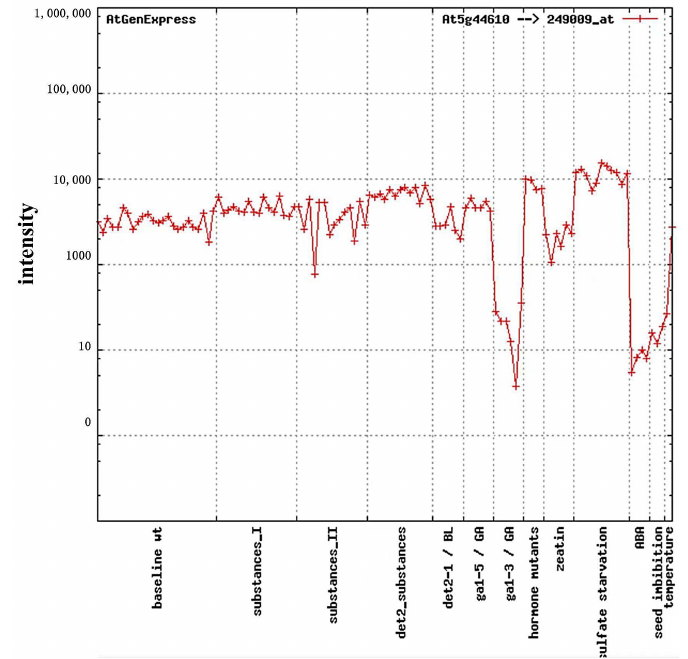
Figure A2. The AtGenExpress Visualization Tool (AVT) analysis of the TAIR database showed that the expression of microtubule-associated protein 18, MAP18, a microtubule destabilizing protein in A. thaliana ( At5g44610 ), was regulated by ABA. Genes 2023 , 14 , 892